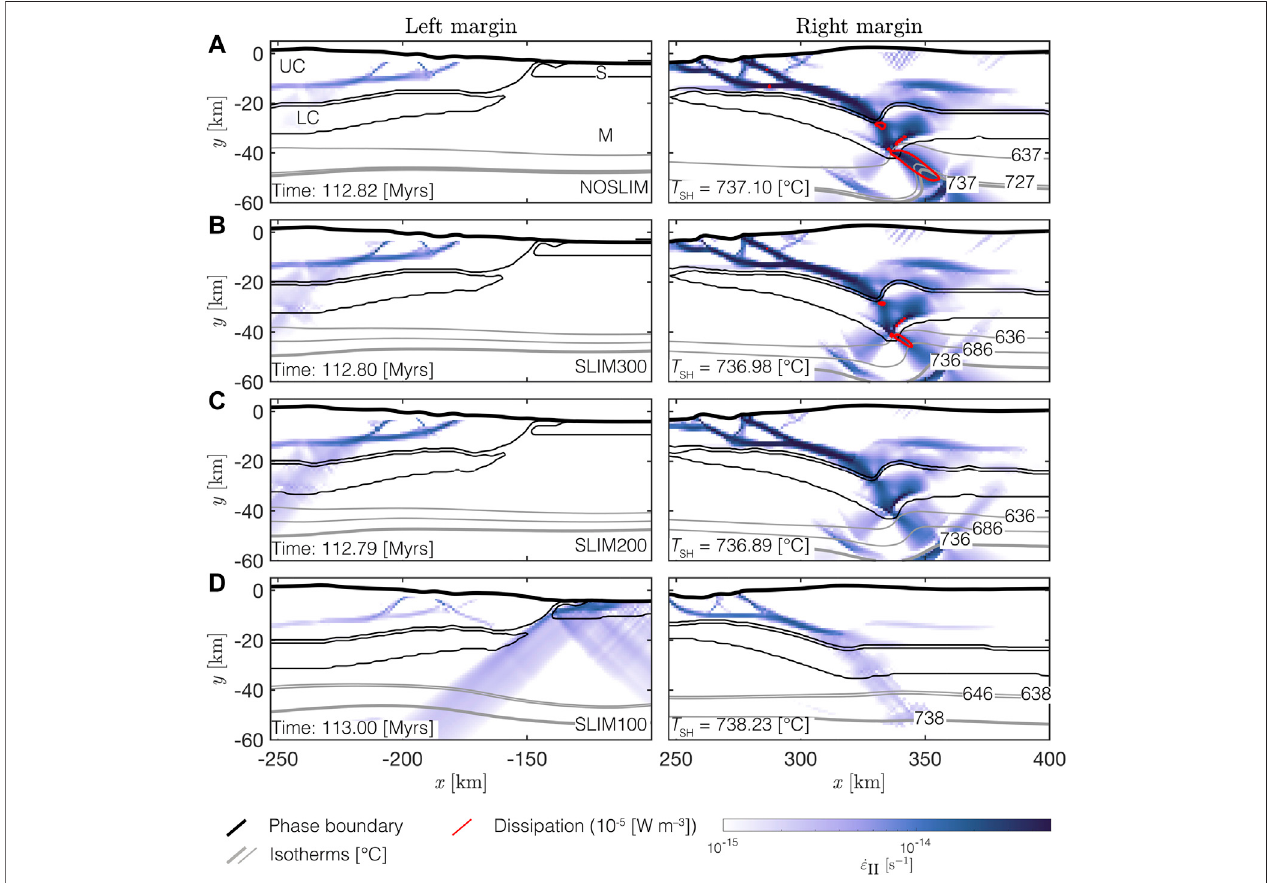
FIGURE4| Subductioninitiationviathermalsofteningformodelswithdifferentappliedstresslimits: (A) nostresslimit, (B) 300MPa, (C) 200MPaand (D) 100MPa. White to dark blue is the second invariant of the deviatoric strain rate tensor, solid grey lines are several isotherms used to estimate the temperature rise inside the shear zone based on their vertical position, the red contour indicates the dissipation and black solid lines are material phase boundaries. The left column shows the left margin and the right column shows the right margin. For decreasing stress limits, the dissipation inside the evolving shear zone is signi fi cantly reduced and the T SH (an analytically predicted temperature; see text for details) isotherm is less de fl ected upward indicating that thermal softening (shear heating) becomes less important for shear localization and, thus, for subduction initiation at the passive margin.